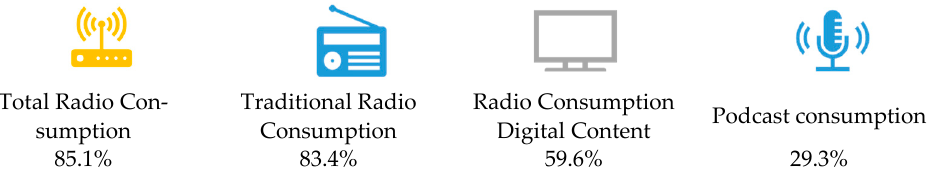
Figure 3. Consumption of sound content in Colombia. Source: author’s elaboration with data from Asociación Colombiana de Investigación de Medios 2020.